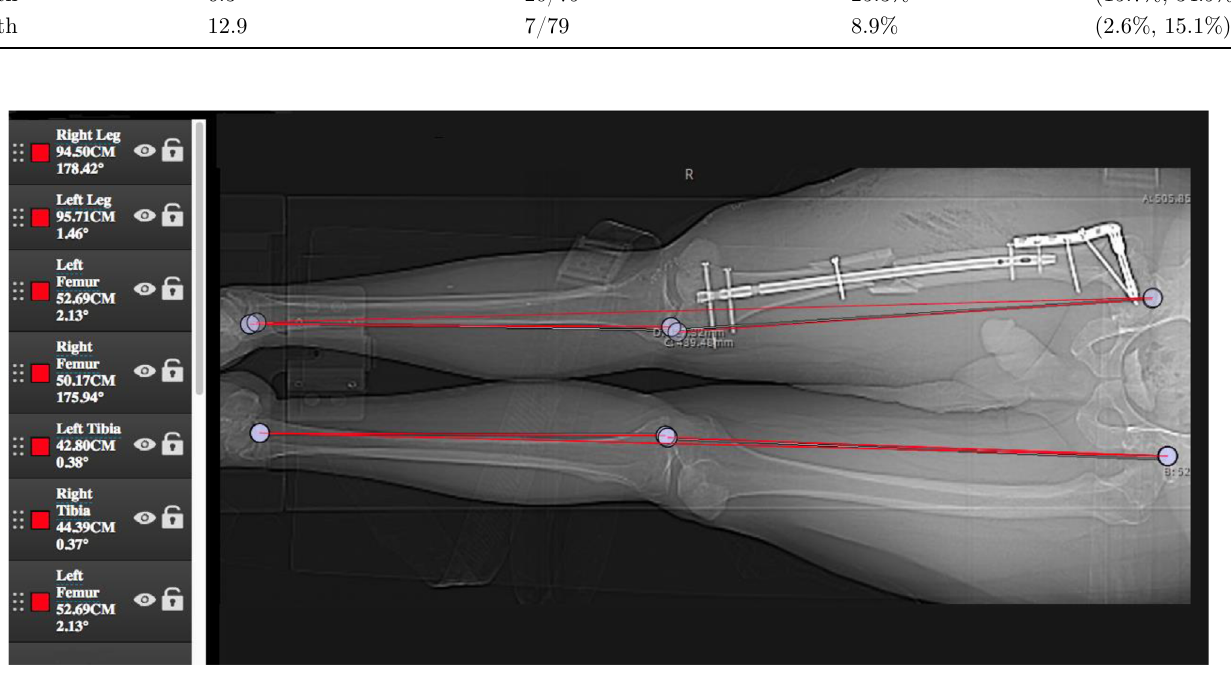
Figure 1. This 40-year patient with a right previous proximal femoral fi xation and new right comminuted femur fracture appears to be nailed with a (cid:1) 2.42 cm (shortening) of this right femur compared to the left femur. However, due to a Tibia LLD of +1.59 cm (inherently longer) on the right side, he has a balancing of the overall LLD of < 0.5 cm, which is and was tolerable for him.